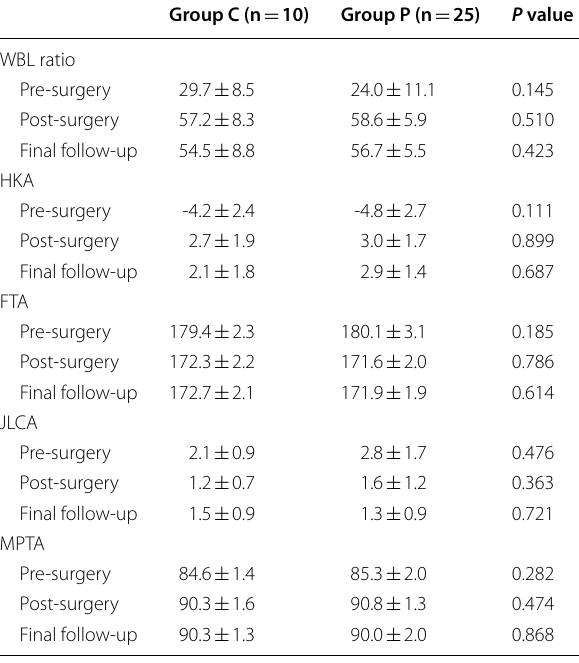
Table 3 Clinical evaluation before and after surgery Table 4 Radiographic evaluation before and after